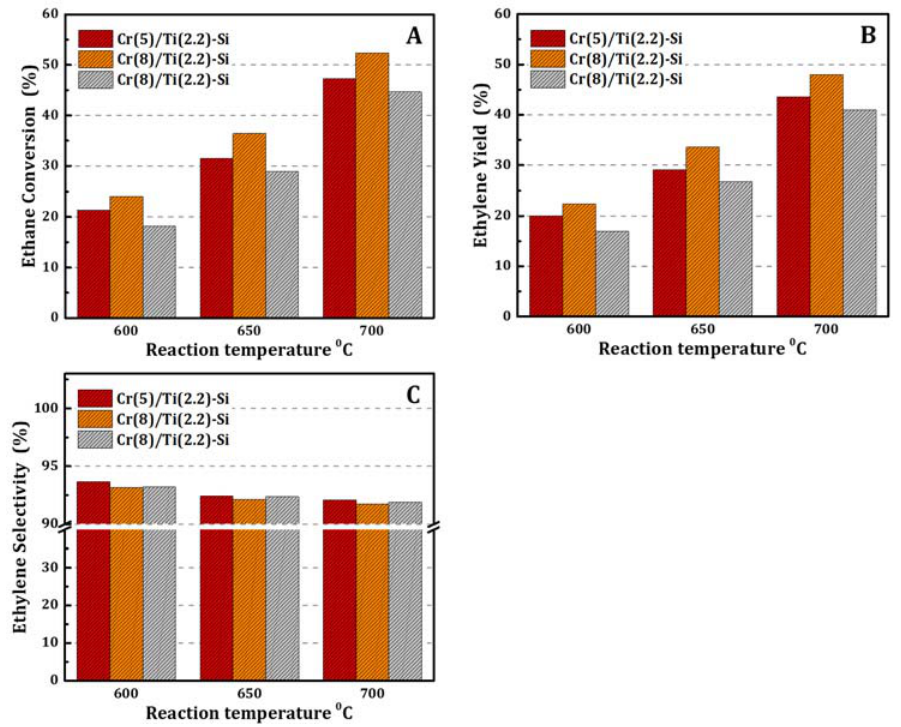
Figure 8. Effect of Cr loading on ( A ) ethane conversions, ( B ) ethylene yield ( C ) and selectivity of Cr(y)/Ti(2.2)–Si nanocomposite catalysts at various reaction temperatures.